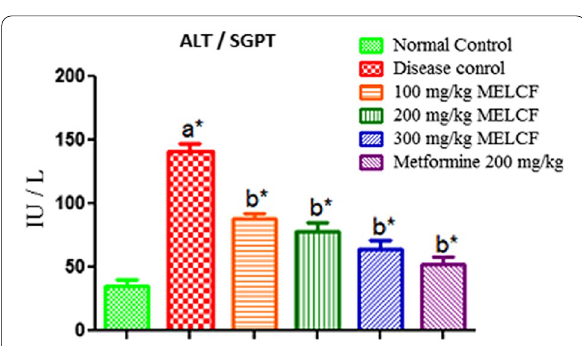
Fig. 9 Effect of MELCF on ALT/SGPT. The values represented as mean SEM ( n 6). a* ( p < 0.05) when compared to normal control ± = and b* ( p < 0.05) when compared to disease/diabetic control